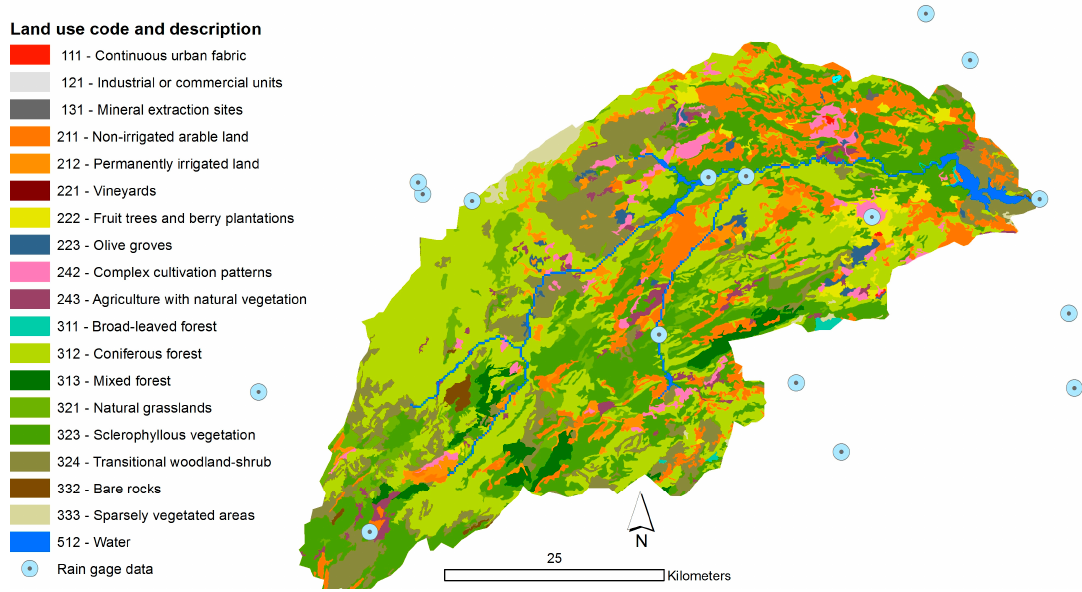
Figure 1. Land use of the Upper Segura basin (source: CLC2006)